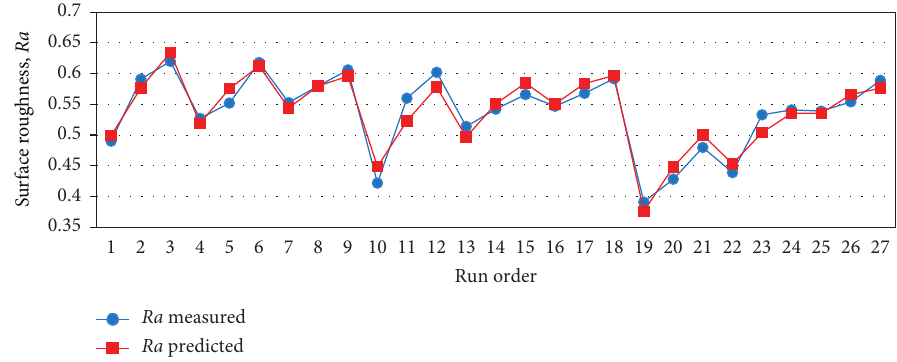
Figure 4: Matching of experimental and RSM values for surface roughness.